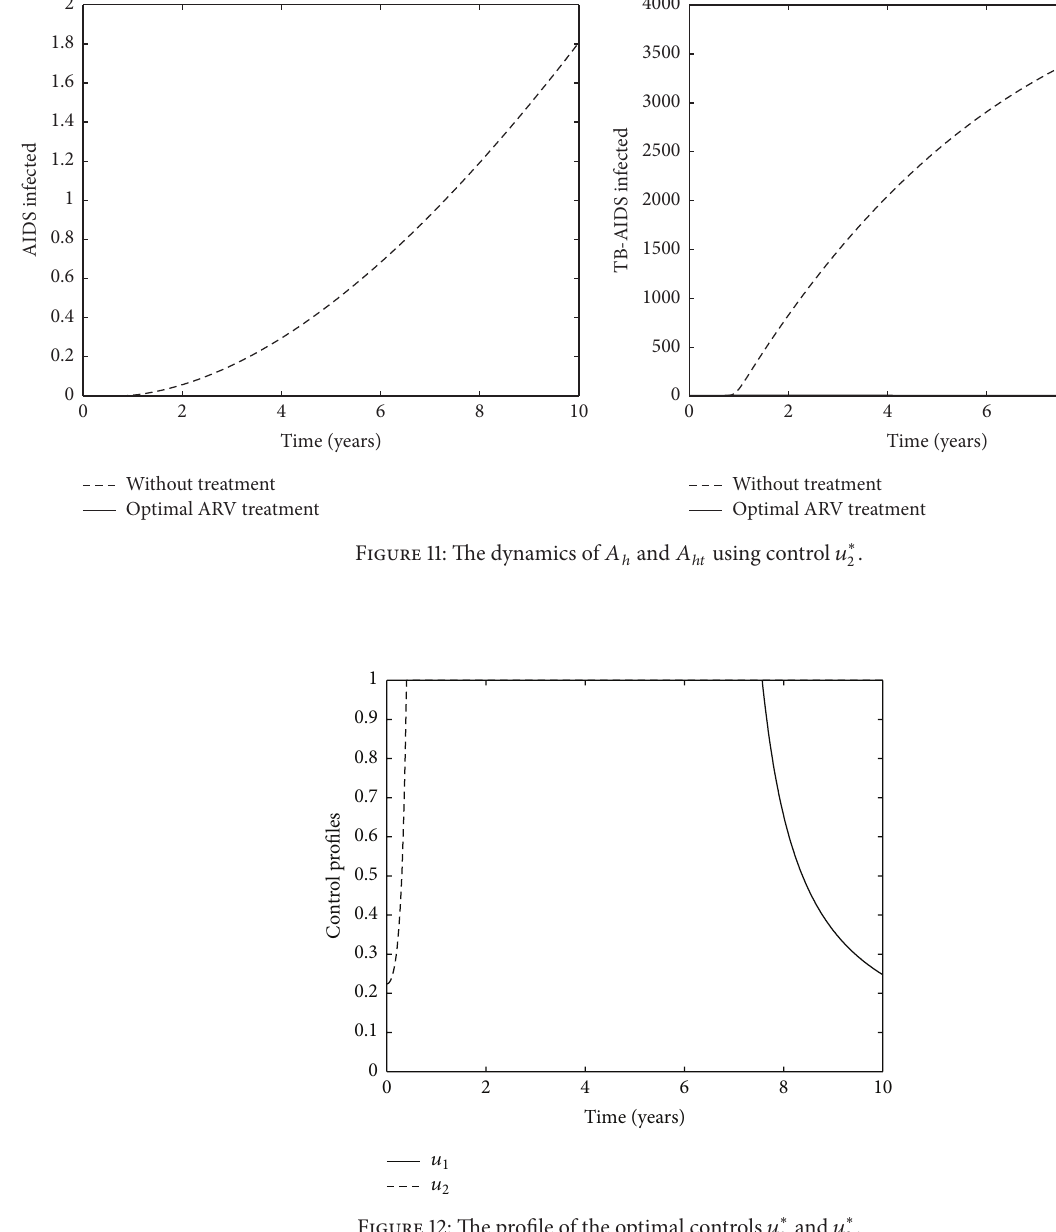
Figure 12: The profile of the optimal controls 𝑢 ∗ 1 and 𝑢 ∗ 2